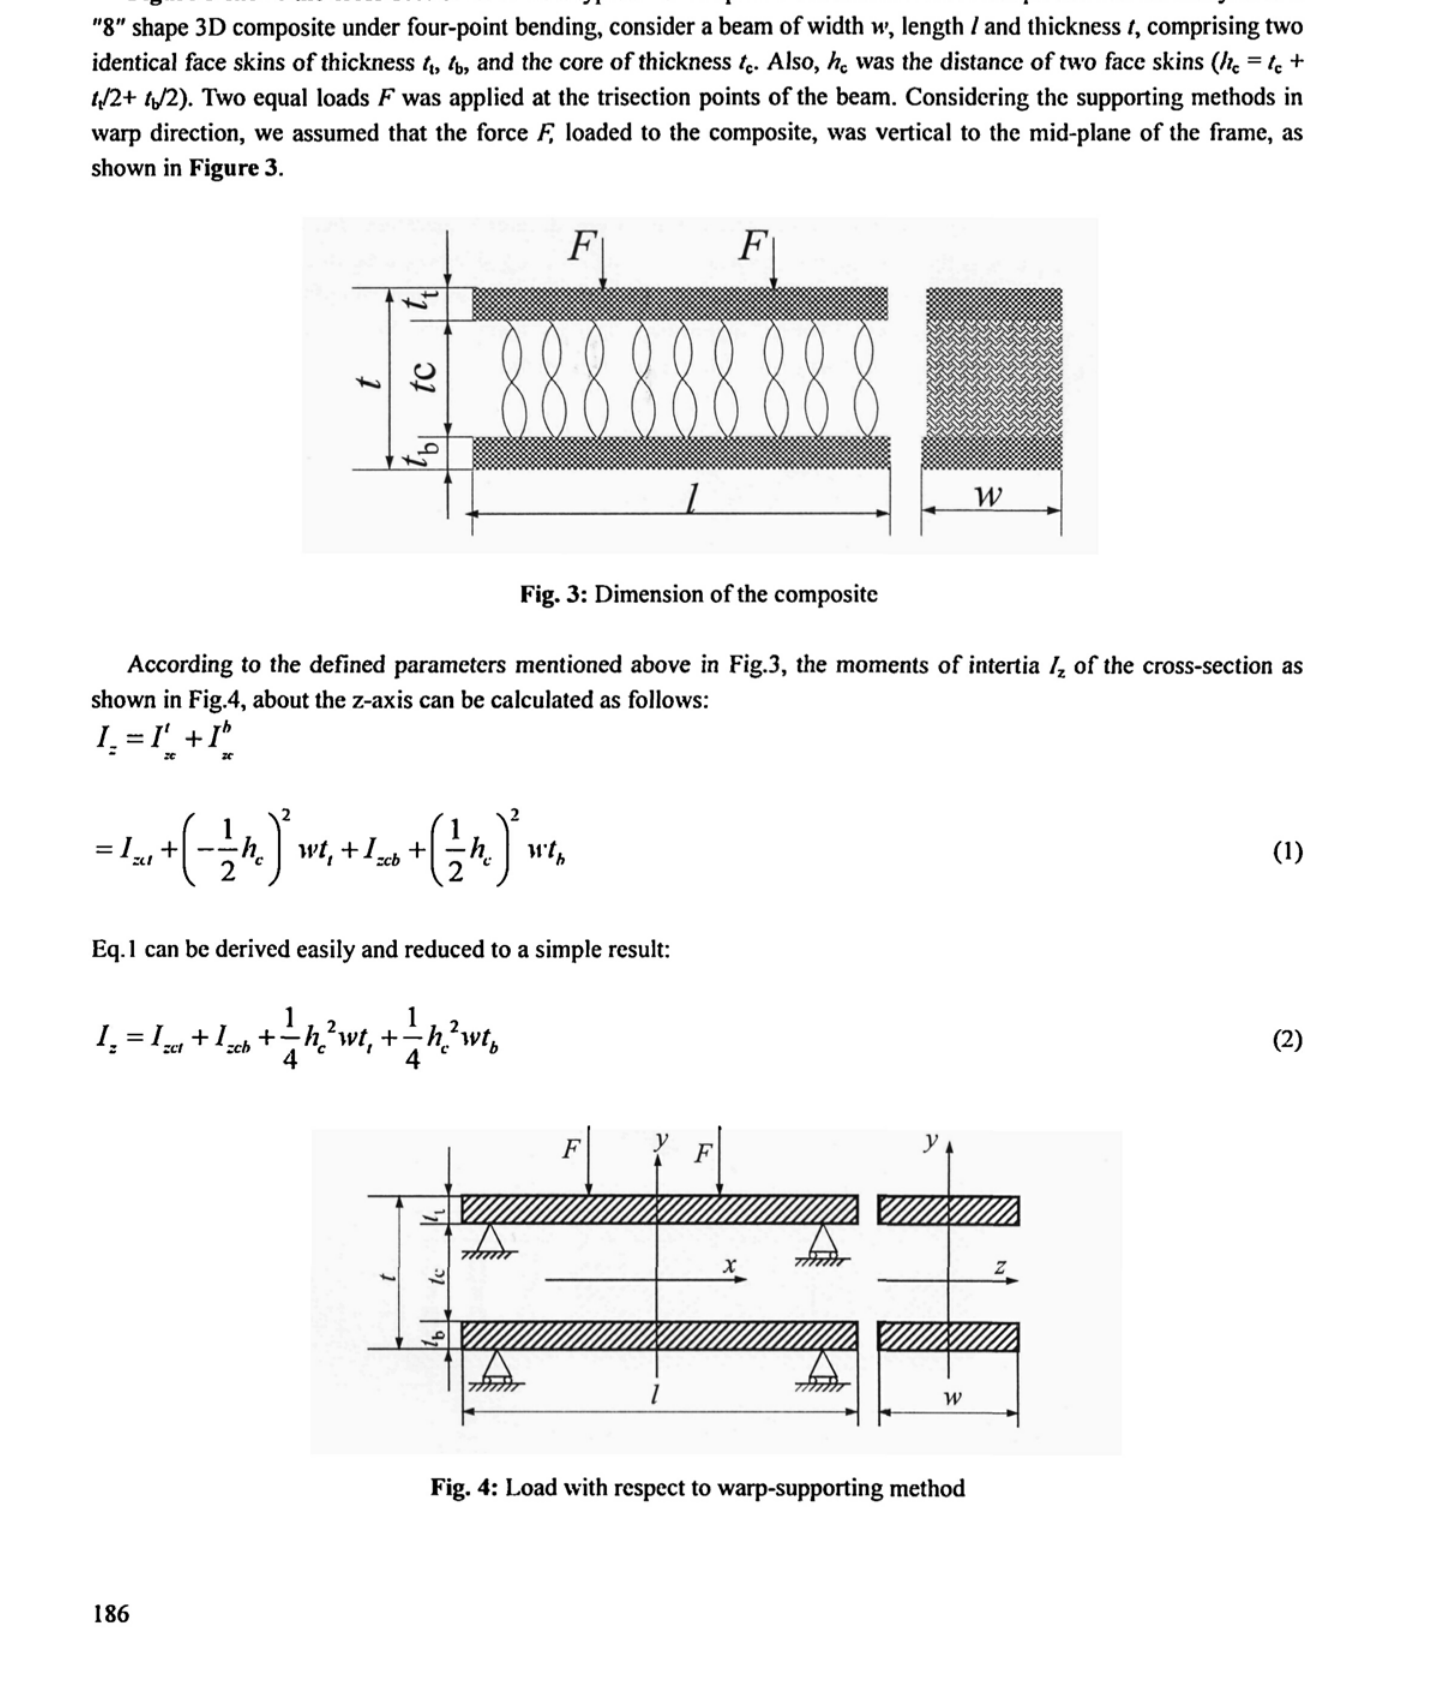
Fig. 4: Load with respect to warp-supporting